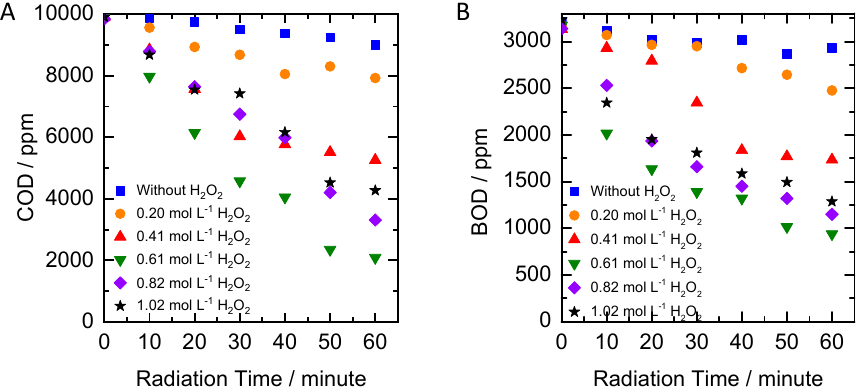
Figure 3. ( A ) COD and ( B ) BOD degradation of textile wastewater with concentration of hydrogen peroxide variation.